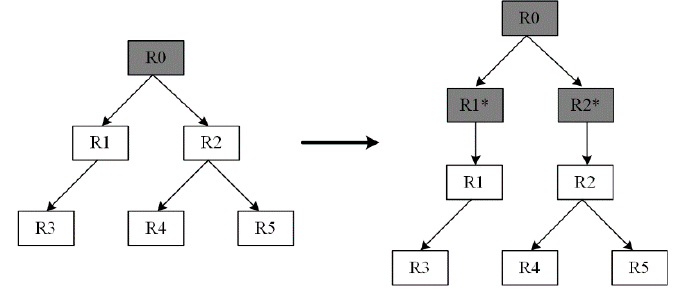
Figure 5. Rule-caching with Cover-Set.